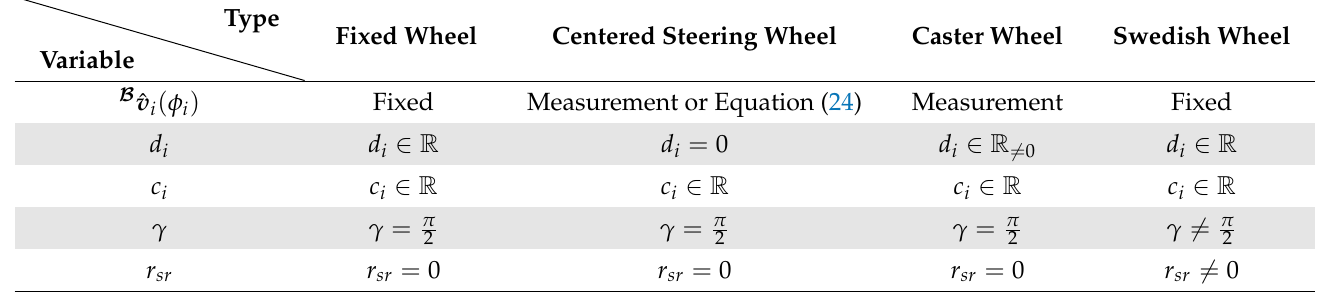
Table 2. GW Parameters for each Type of